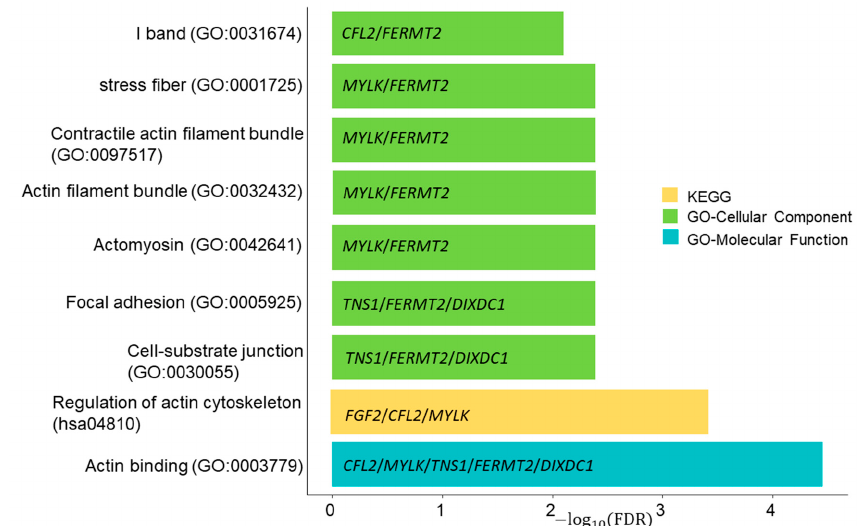
Figure 4. Functional enrichment analysis of nine genes in the shared competing endogenous RNA network of hormone ‐ dependent (HD) cancers. There were seven, one, and one statistically significant component(s) in the GO CC, GO MF, and KEGG pathways, respectively. Six out of nine genes, CFL2 , MYLK , TNS1 , FERMT2 , DIXDC1 , and FGF2 are associated with actin ‐ related pathways.